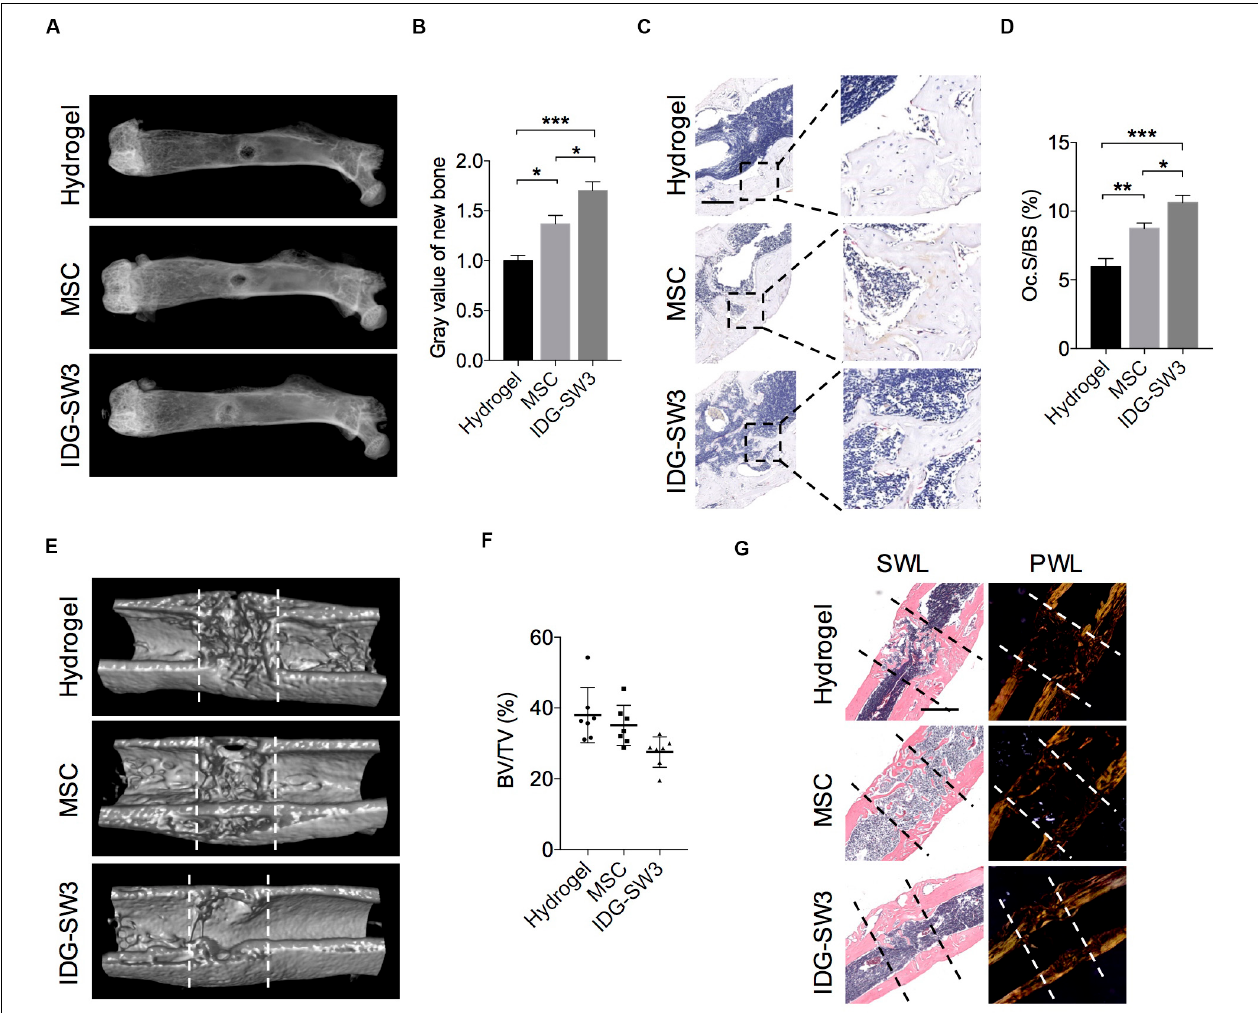
FIGURE 5 | Improved drill-hole bone healing in estrogen-deficient mice with IDG-SW3 cells. (A–D) After drill-hole surgery for 1 week, mice were sacrificed and the right femora were subjected to radiographic and histological examination ( n = 5). (A) Representative X-ray images. (B) Grayscale analysis of the new bone formed in defect area. (C) Representative TRAP staining images of the defect area. Bar, 200 µ m. (D) Quantification of the TRAP staining by osteoclast surface per bone surface (Oc.S/BS). (E–G) After drill-hole surgery for 2 weeks, mice were sacrificed and the right femora were subjected to radiographic and histological examination ( n = 7). (E) 3D µ -CT images of the defect area. (F) µ -CT analysis of bone volume per tissue volume (BV/TV) in the intramedulla region. (G) Representative H&E staining images (left) and the relative polarized-light images (right) of the defect area. Data in (E) and (G) were derived from an identical femur. Bar, 500 µ m. Data were represented as means ± s.e.m. Ordinary one-way ANOVA analysis. * P < 0.05. ** P < 0.01. *** P < 0.001. SWL, standard white light; PWL, polarized white